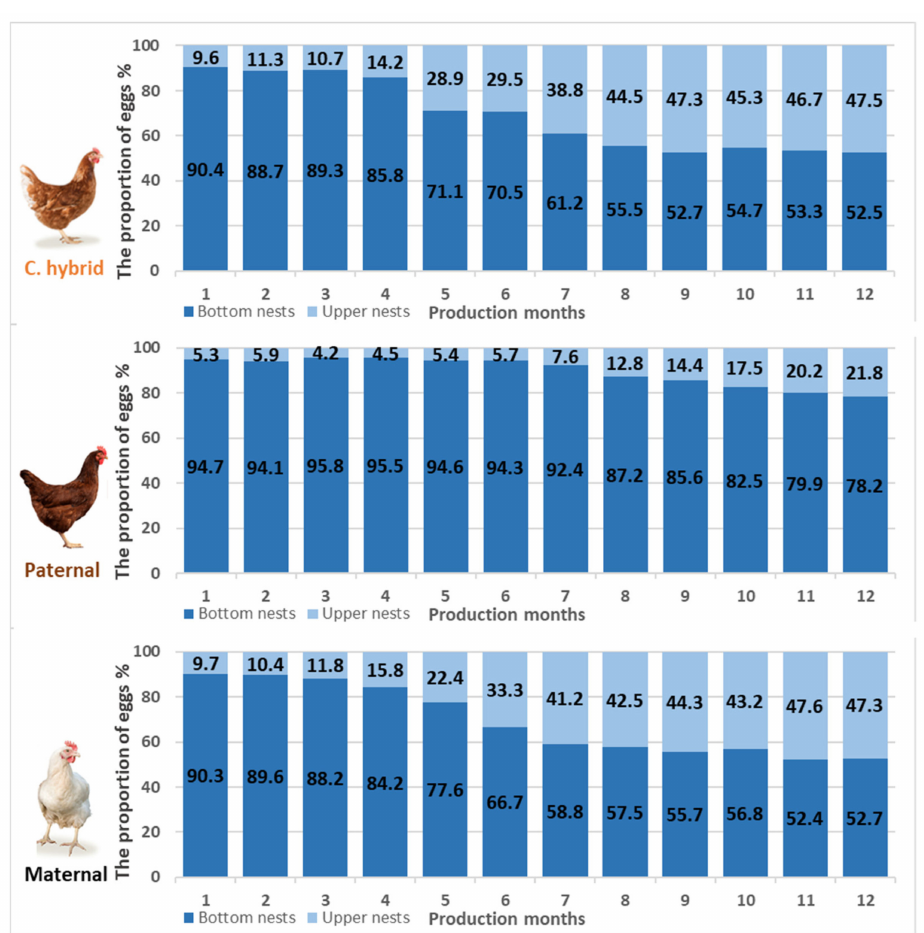
Figure 7. Changes in the proportion of eggs laid in the lower and upper nests during the 12 months of egg production in the case of the different